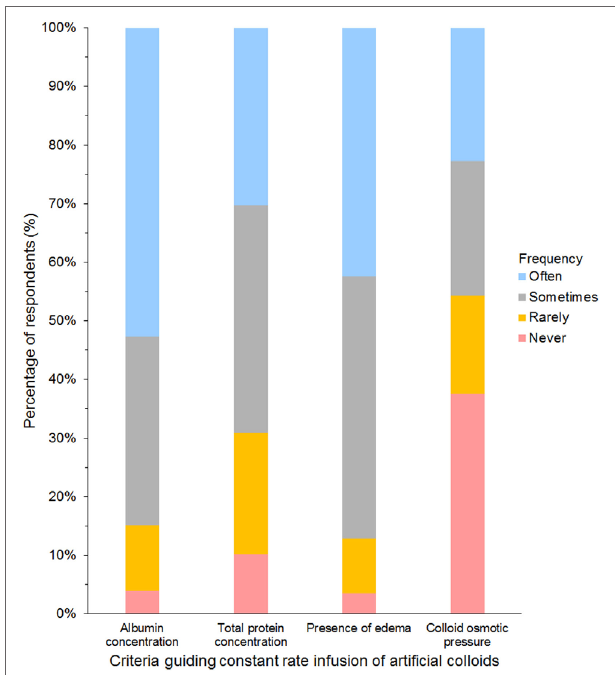
FigUre 9 | Frequency chart showing the relative importance of criteria used to guide the decision to use synthetic colloids as a constant rate infusion reported by 681 survey